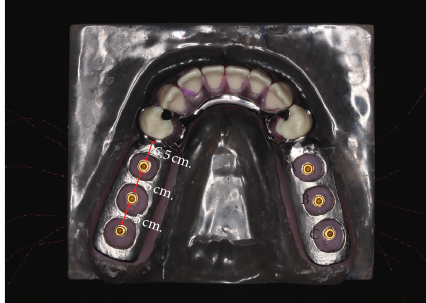
Figure 2: Model of mandibular Kennedy Class I bilateral distal extension missing (35–37 and 45–47) with a